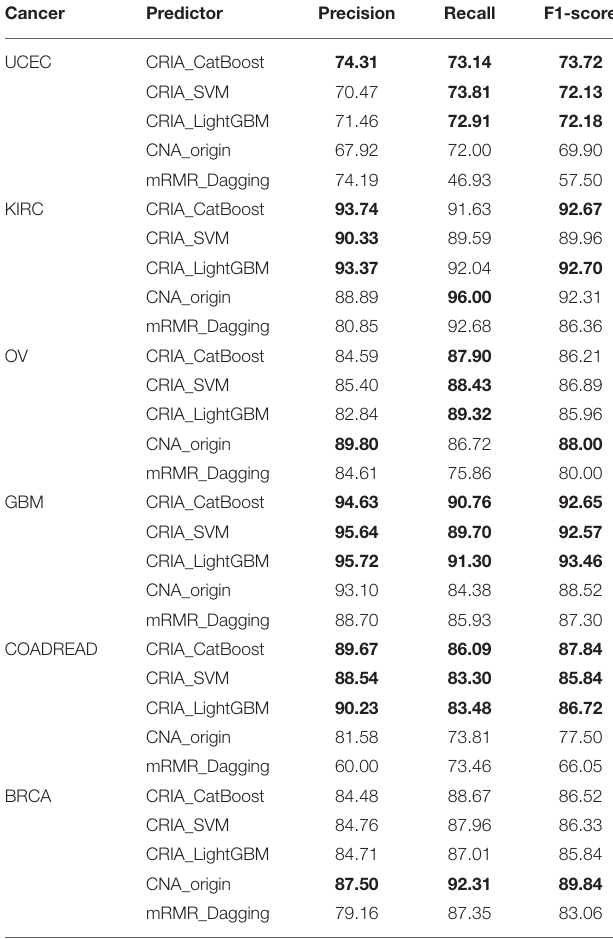
TABLE 8 | Performance comparison of the proposed algorithm predictions with those of other methods (%). Cancer Predictor